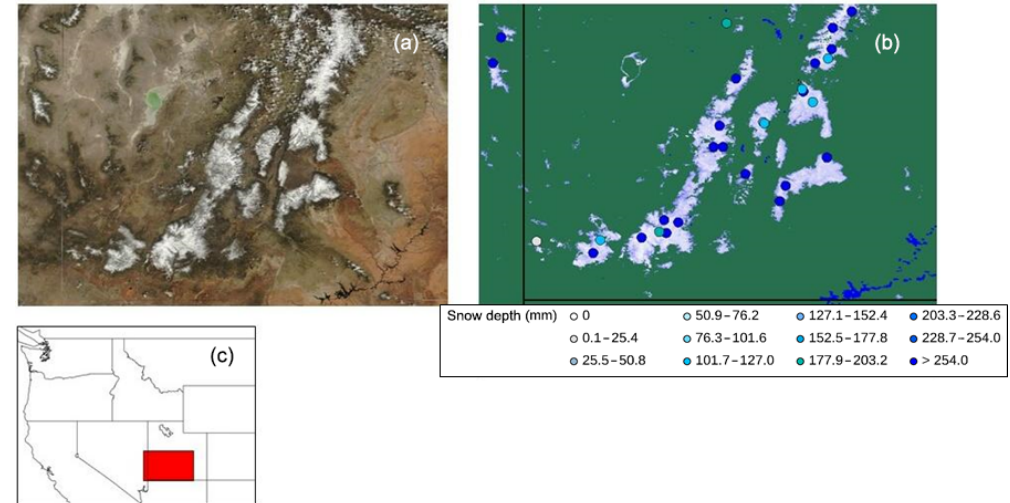
Figure 6. (a) NASA WorldView true-color (corrected reflectance) Terra MODIS image of a region on interest (ROI) in central Utah, USA, including the southern part of the Wasatch Range, acquired on 16 April 2012. (b) Snow depths from NOAA are mapped onto the Terra MODIS CGF map, MOD10A1F, for 16 April 2012 for the same area shown in (a) . (c) Location map that shows a red box which delineates the ROI. The base map in (b) and the location map in (c) were obtained from Interactive Data Language (IDL) software package that uses Natural Earth raster + vector map data, which are in the public